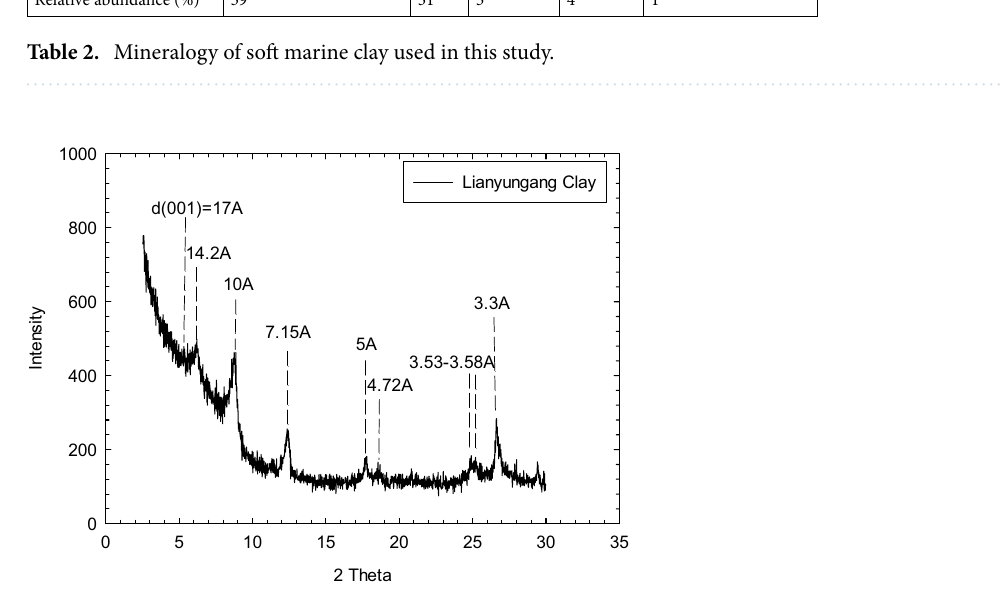
Figure 2. X-ray diffraction (XRD) scan pattern of Lianyungang